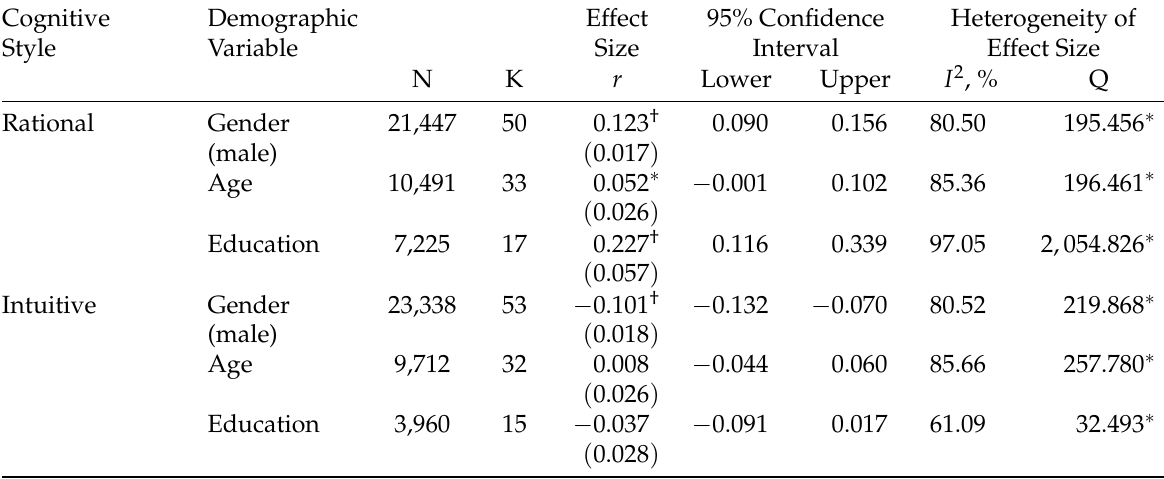
Table 1: Summary of Meta-Analyses for Rational and Intuitive Cognitive Styles Cognitive